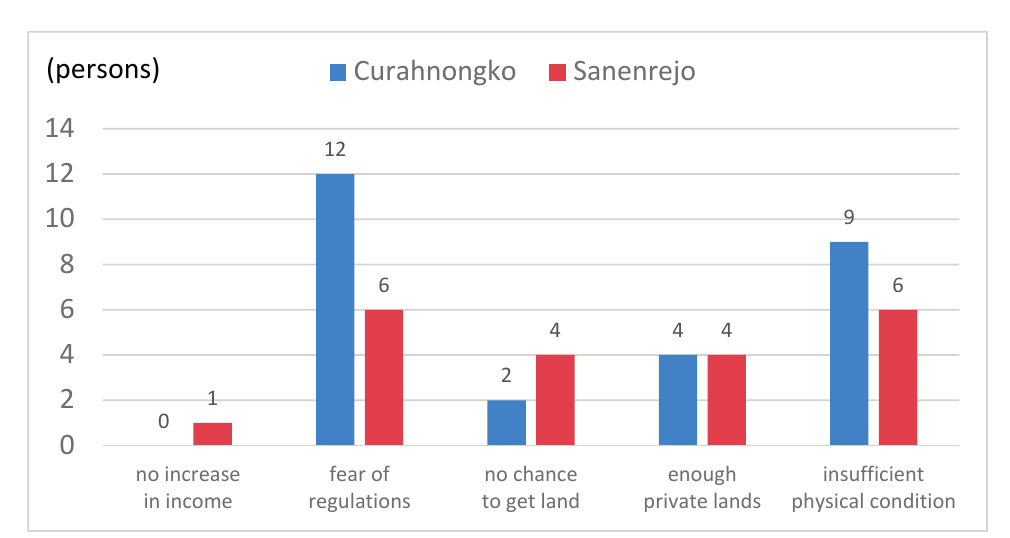
Figure 3. Local people’s reasons for not participating in the rehabilitation